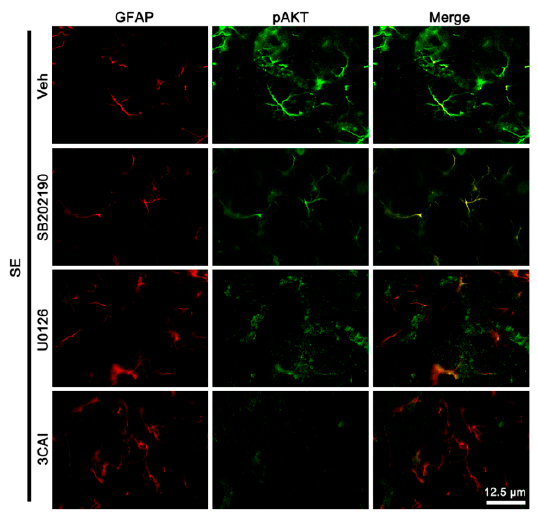
Figure 7. The effects of kinase inhibitors on localizations of pAKT expression in the PC following SE. Compared to the vehicle, SB202190 and U0126 reduce pAKT signal in endothelial cells and astrocytes, respectively. 3CAI diminishes it in both endothelial cells and astrocytes.